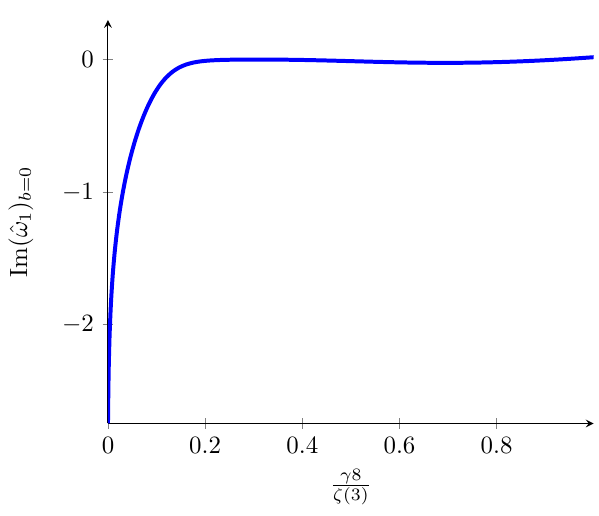
Figure 9 . The imaginary part of the coupling correction resummed (cid:12)rst QNM frequency for b = 0 on the (cid:13) -interval that corresponds to (cid:21) becomes very small and approaches 0, re(cid:13)ecting that for weak interaction the equilibration time becomes extremely